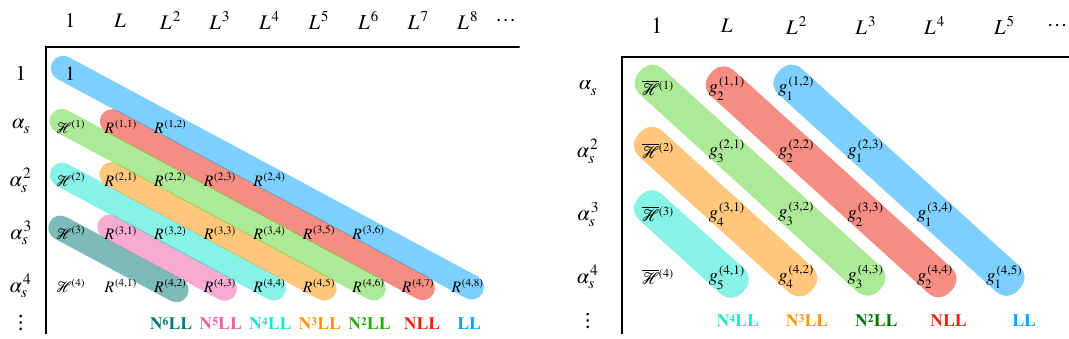
Figure 2 . Graphical representation of logarithmic countings: in the left panel the counting is done at the level of the cross section, in the right panel at the level of the logarithm of the cross section. at O (1), at NNLL and N 3 LL they need to include the O ( (cid:11) ) corrections, and so on. This s logarithmic counting is illustrated in the left panel of (cid:12)gure 2: the diagonal bands represent the terms included in each R , with H ( n ) the perturbative coe(cid:14)cients of either H or C N k LL or a combination of the